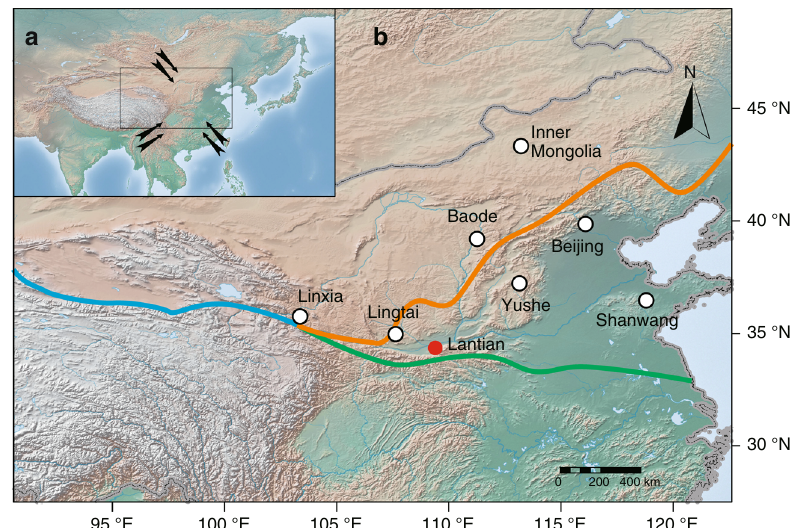
Fig. 1 Climate of the study area and the vegetation distribution in East Asia. a Landform of Eurasia and the climate of East Asia; the prevailing modern atmospheric circulation patterns are indicated by arrows. b Localities referenced in the text and fi gures. Red dot: location of the study site; open black dots: locations mentioned in the text. Solid lines: boundaries between modern vegetation. Green line: the boundary between forest and grasses. Orange line: the boundary between C 3 grasses and C 4 grasses. Blue line: the boundary between modern desert steppe and alpine meadow. The distribution of modern vegetation is from the Chinese terrestrial ecosystem database (http://www.ecosystem.csdb.cn). The images of landform are from (https://maps.ngdc.